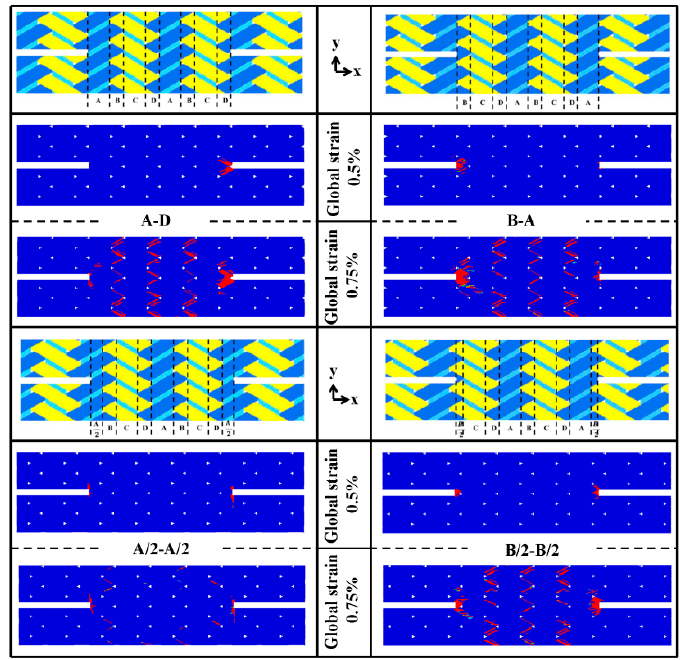
Figure 9. Numerical predictions of matrix damage in fiber bundles for notched tension specimen with different architectures across the gauge section.